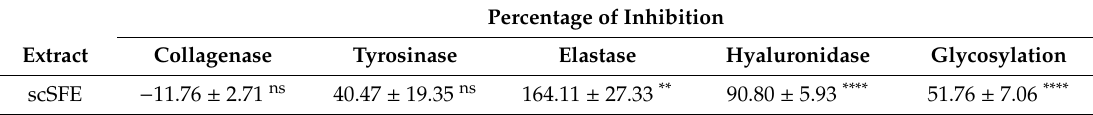
Table 6. Determination of the inhibition (%) ± SD of collagenase, tyrosinase, elastase, hyaluronidase, and glycosylation by scSFE. ** ( p < 0.01) and **** ( p < 0.0001) indicate statistically significant di ff erences compared to the corresponding untreated negative control; ns: not statistically